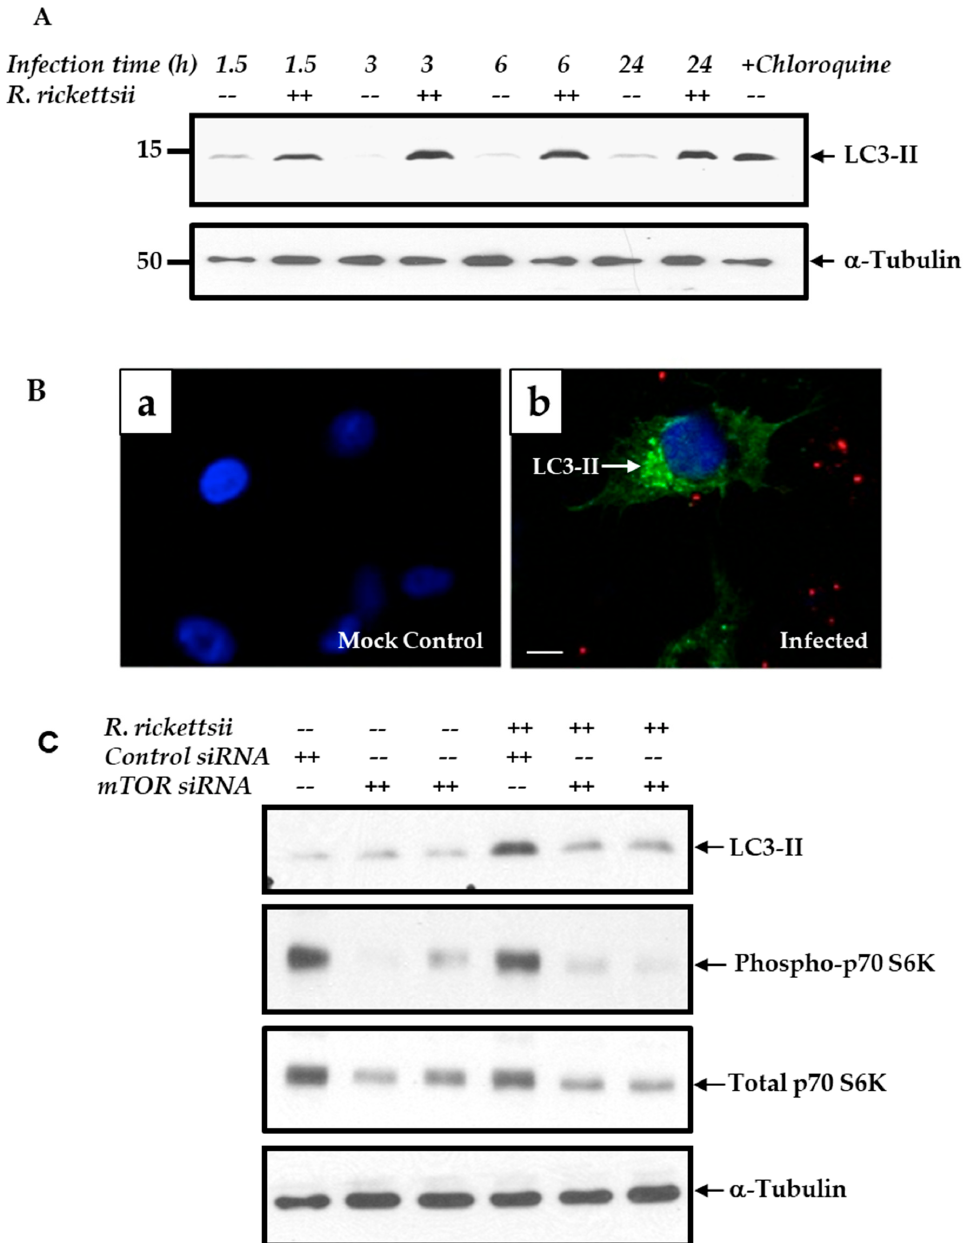
Figure 4. LC3-II lipidation in R. rickettsii -infected ECs. ( A ). Confluent ECs were either mock infected (–) or infected with R. rickettsii ( ++ ) for various times as indicated. Cell lysates were then prepared and subjected to immunoblot analysis with antibodies against LC3-II. An antibody to probe for α -tubulin was used as a loading control and relative positions of nearest molecular weight markers (kDa) from the protein ladder are indicated on the left flank of the gel. A representative blot ( n ≥ 3) is presented. ( B ). ECs were plated on sterile plastic coverslips and either mock infected ( a ) or infected with R. rickettsii ( b ) for 6 h. Cells were washed, fixed, permeabilized, and stained for LC3-II using a rabbit polyclonal anti-LC3-II (Alexa Fluor 488, Green) and a guinea pig anti- R. rickettsii antibody (Alexa Fluor 568, Red). Cells were counterstained with DAPI to stain the nuclei (blue). Scale Bar = 5 µ m. ( C ). ECs was transfected with 25 nM or 50 nM of mTOR siRNA along with 50 nM of control siRNA for 48 h prior to infection with rickettsiae for 24 h. Total protein lysates were used for performing Western blotting and resultant blots were probed with antibodies for the detection of LC3-II, phospho- and total p70 S6K, and α -tubulin. A representative blot ( n ≥ 3) is